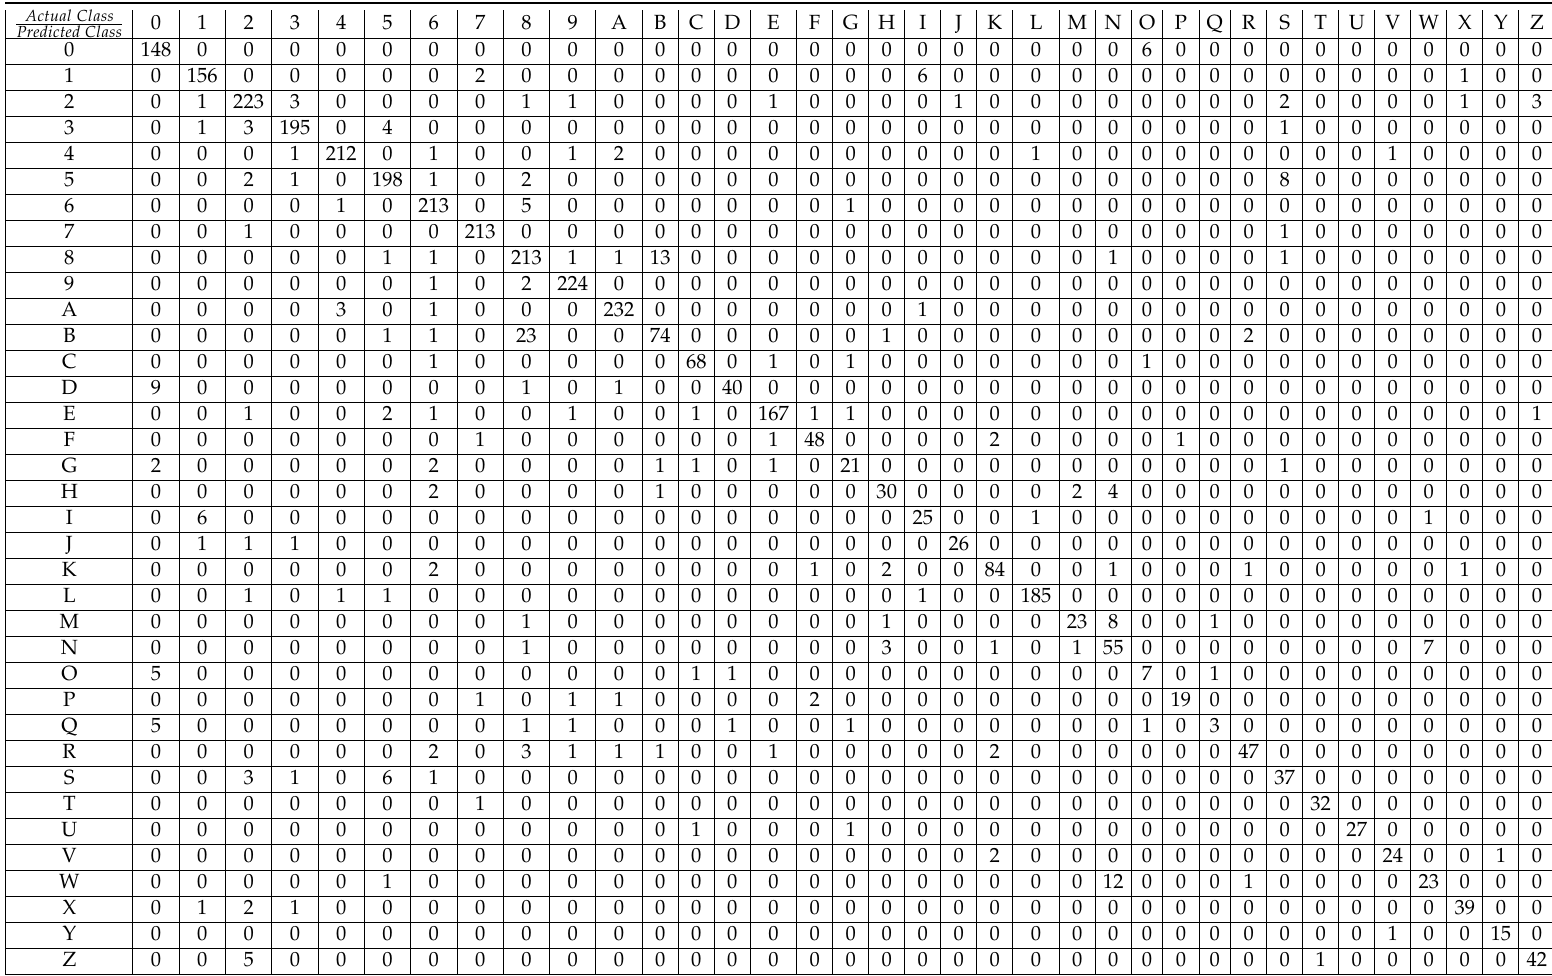
Table 4. Confusion matrix of OCR using KNN classifier